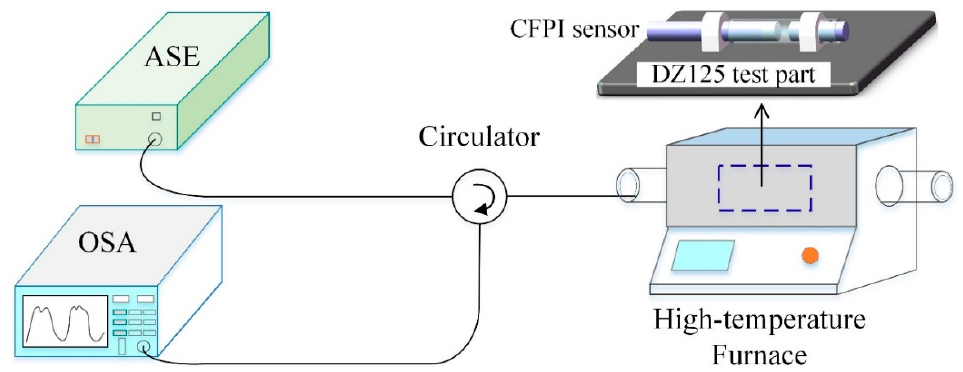
Figure 6. Schematic diagram for high-temperature test setup.